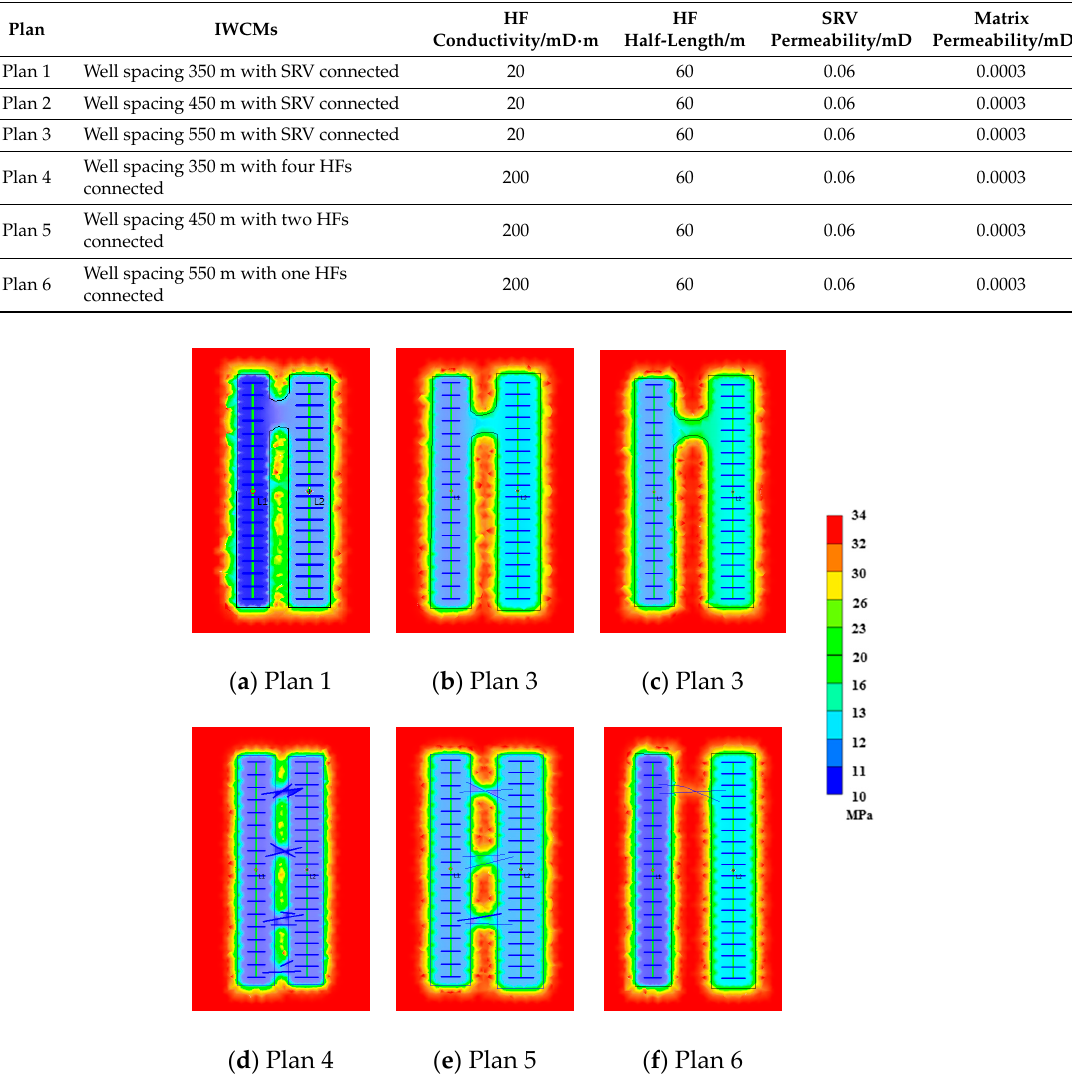
Figure 9. Pressure fields of six plans after producing 15 months under different well spacing.